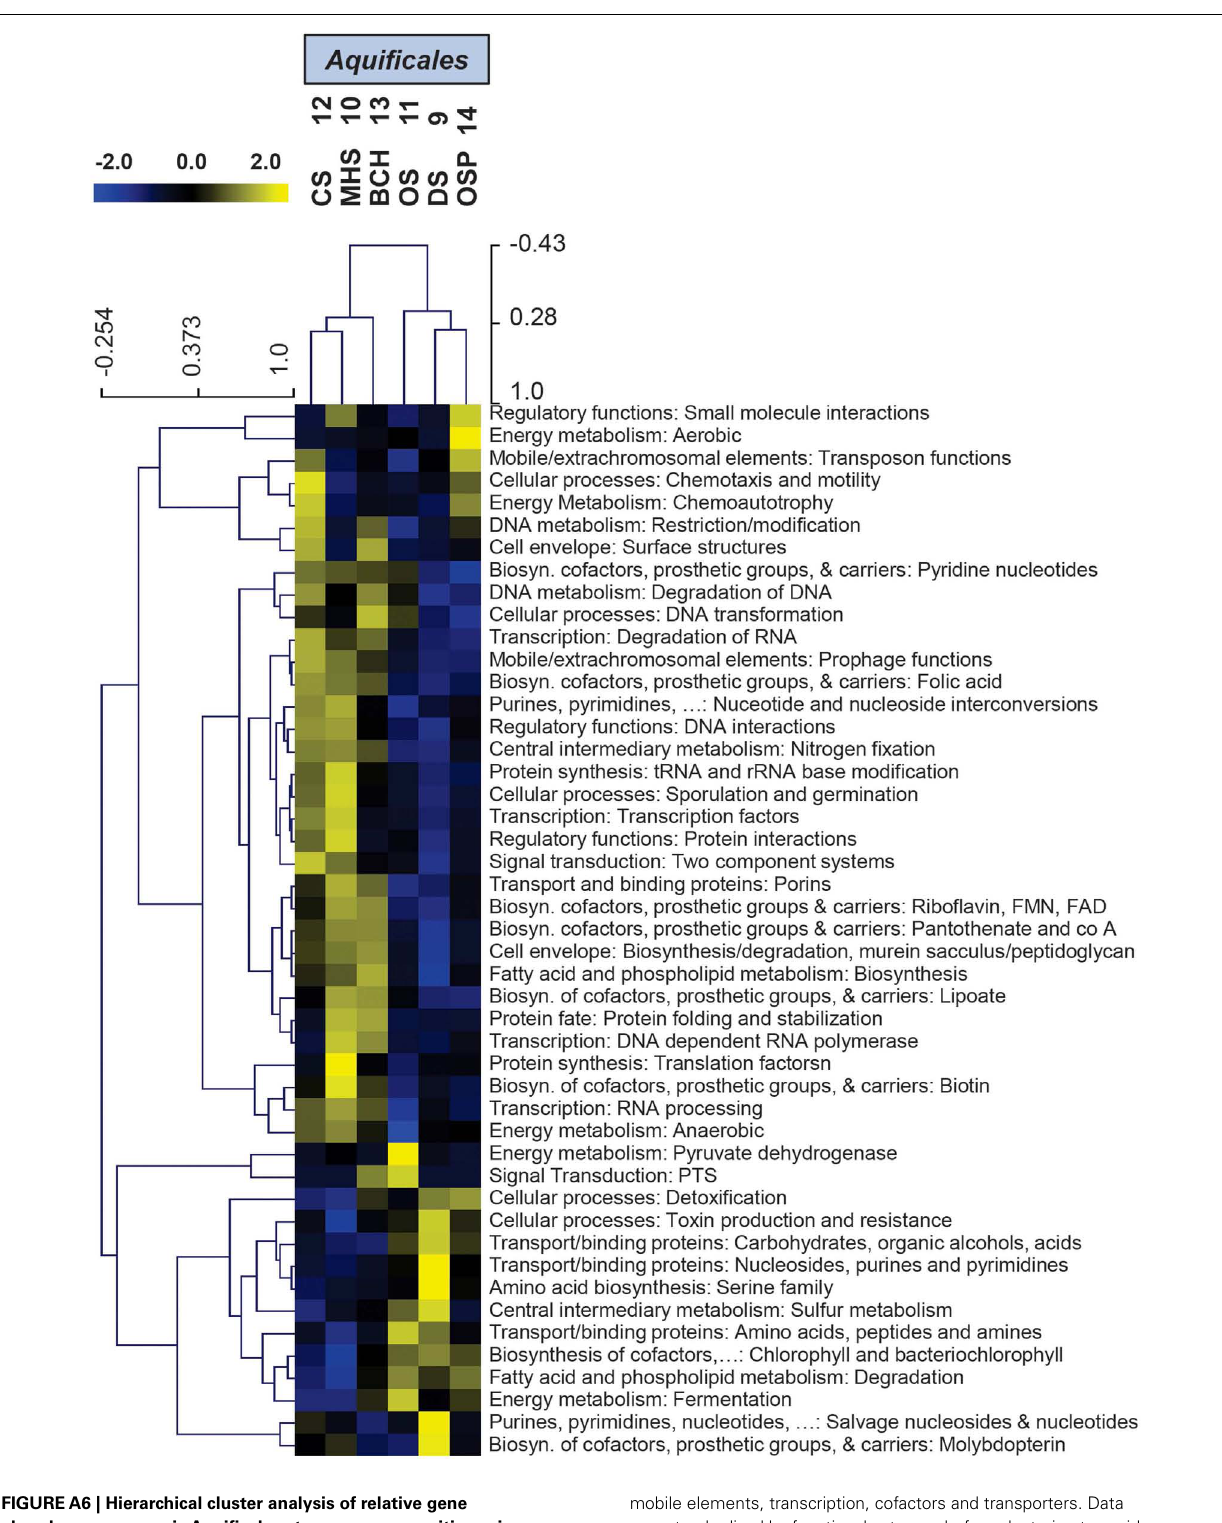
mobile elements, transcription, cofactors and transporters. Data was standardized by functional category before clustering to avoid biasing analysis by a few categories with high gene abundance. Pearson correlation was used as the distance measure for average linkage agglomerative